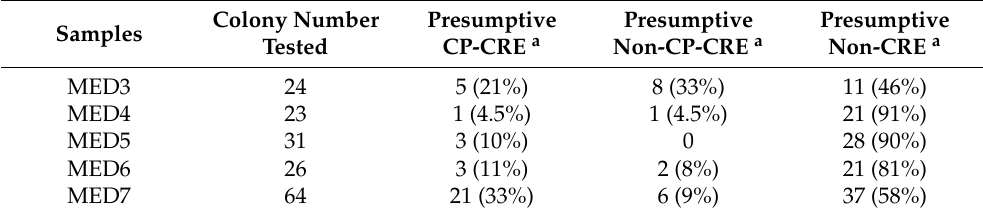
Table 3. Presumptive CP-CRE, non-CP-CRE, and non-CRE isolated from wastewater samples after 24 h of